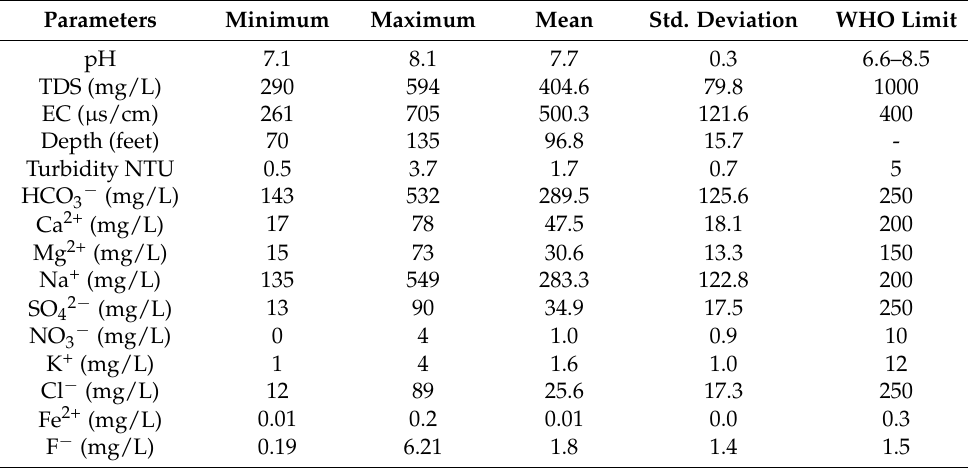
Table 1. Descriptive statistics of selected parameters of drinking groundwater